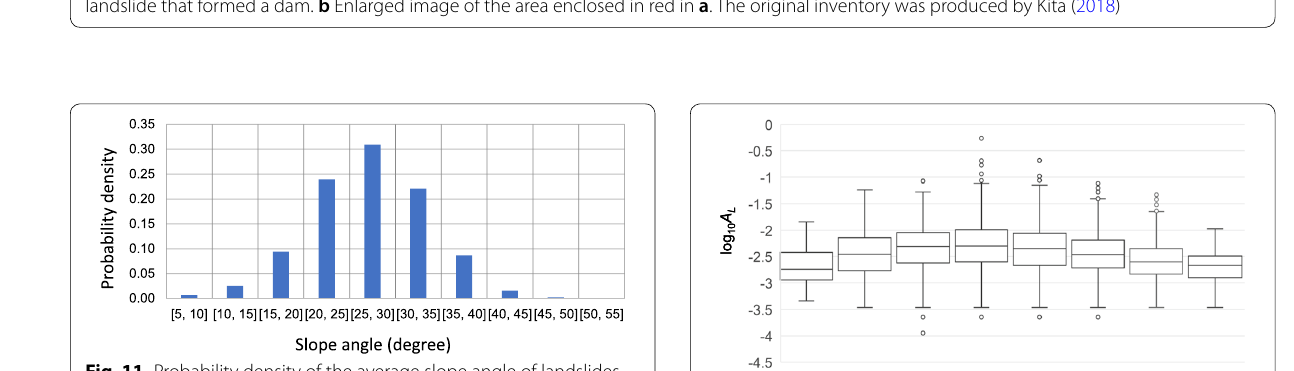
Fig. 11 Probability density of the average slope angle of landslides